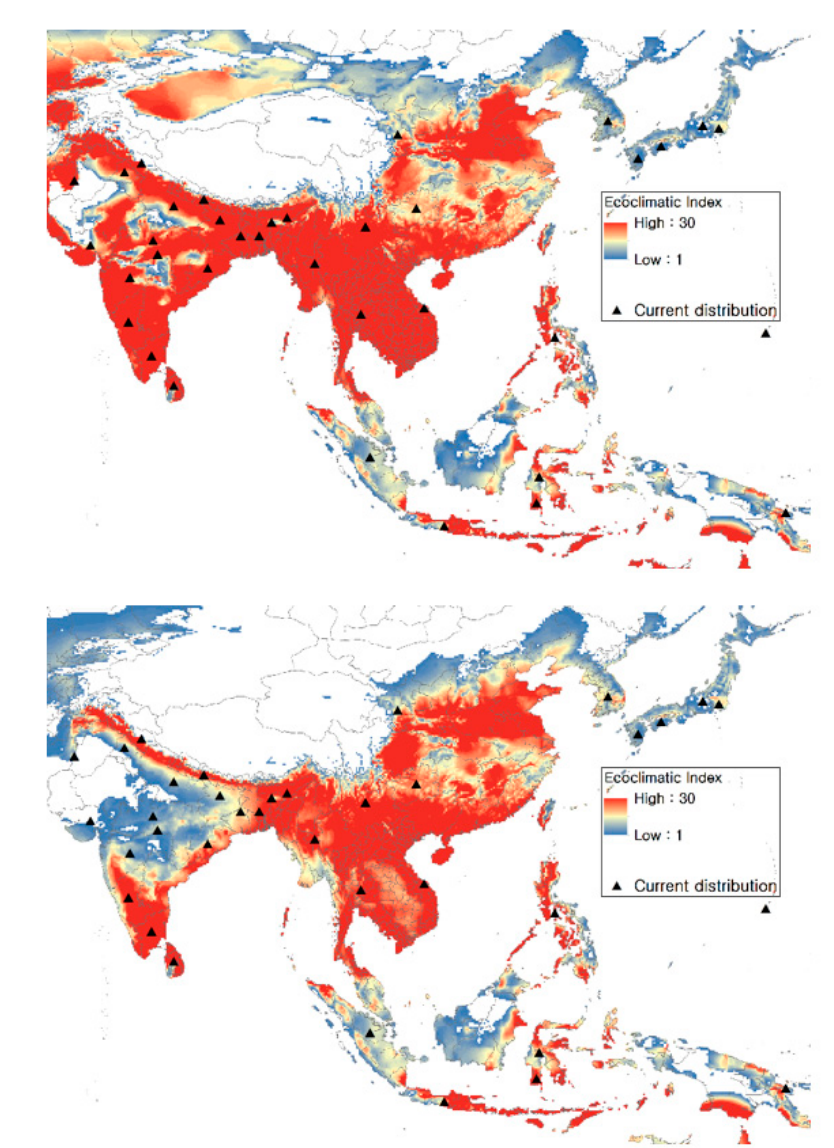
Figure 3. Potential distribution of potato tuber moth in East Asia. ( A ): With irrigation scenario, as per Jung et al. [39], and ( B ): Without irrigation scenario.